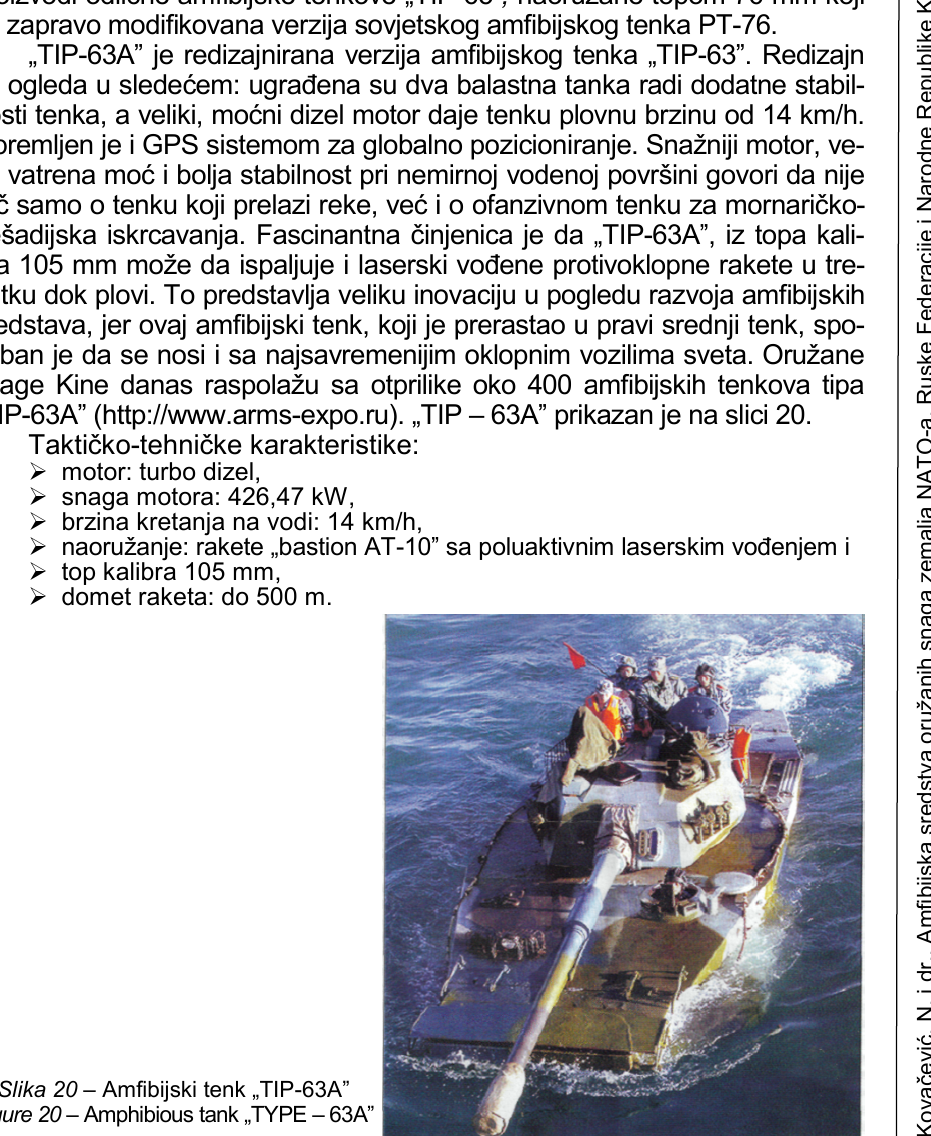
Figure 20 – Amphibious tank „TYPE –